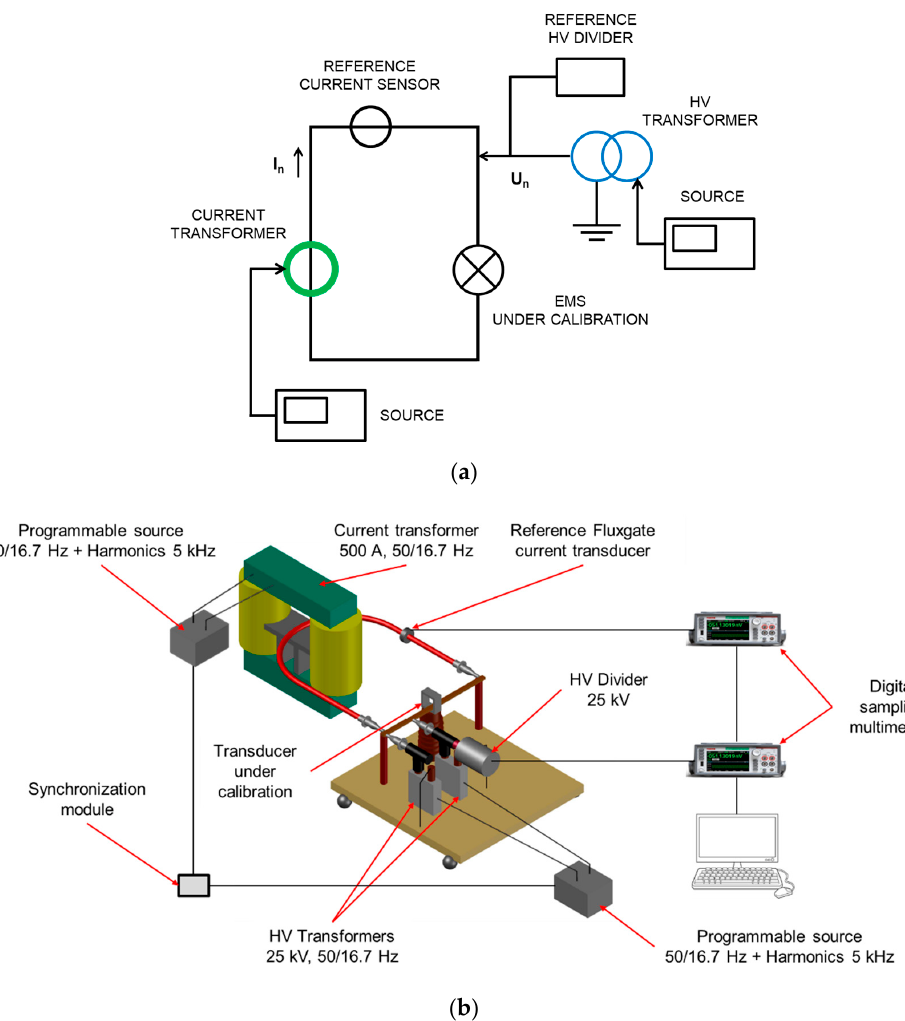
Figure 5. ( a ) Conceptual circuit, ( b ) Scheme of the calibration setup developed by LCOE.